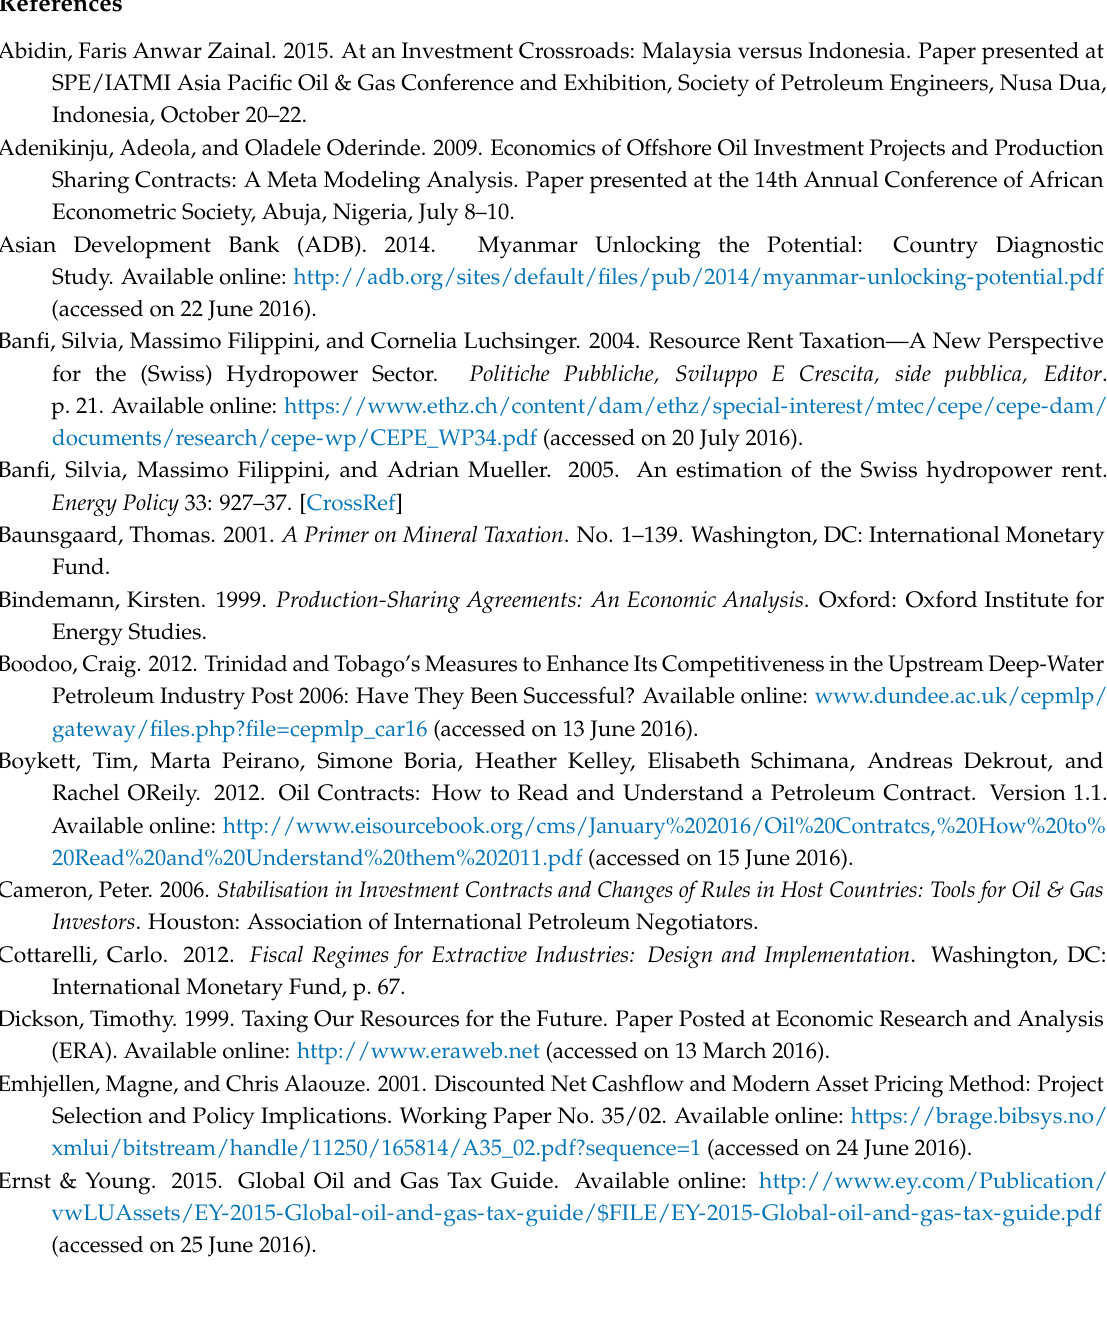
(Cont.), Table S13: Concessionary Australia Cash Flow Projection of Petroleum Exploration & Production, Table S14: Concessionary Australia Cash Flow Projection of Petroleum Exploration & Production (Cont.), Table S15: Concessionary Canada Cash Flow Projection of Petroleum Exploration & Production, Table S16: Concessionary Canada Cash Flow Projection of Petroleum Exploration & Production (Cont.), Table S17: Petroleum Fiscal Regimes of Concessionary